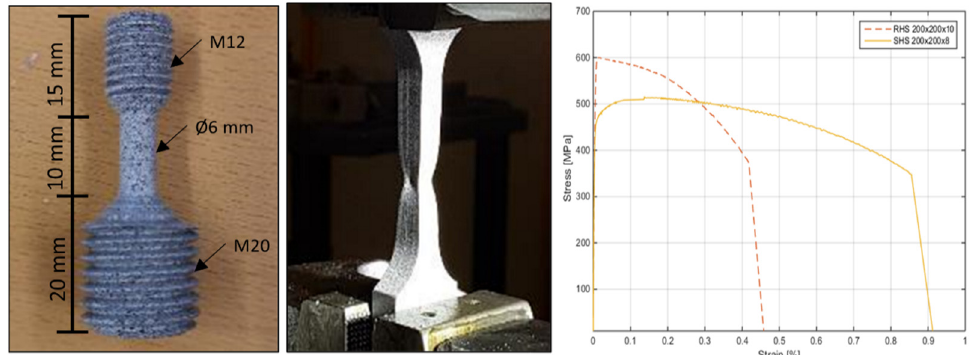
Figure 10. Cylindrical (left) and flat (center) test specimens for studs and tubes, and stress-strain curves of tubes (right). Table 5. Mechanical properties of materials of columns and studs captured in tensile tests.